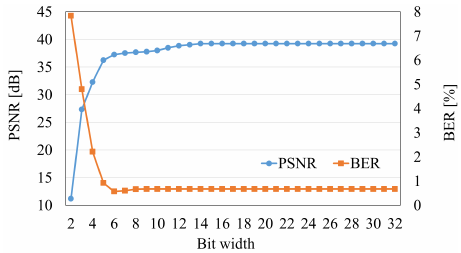
Figure 9. Precision analysis of the tanh number system.